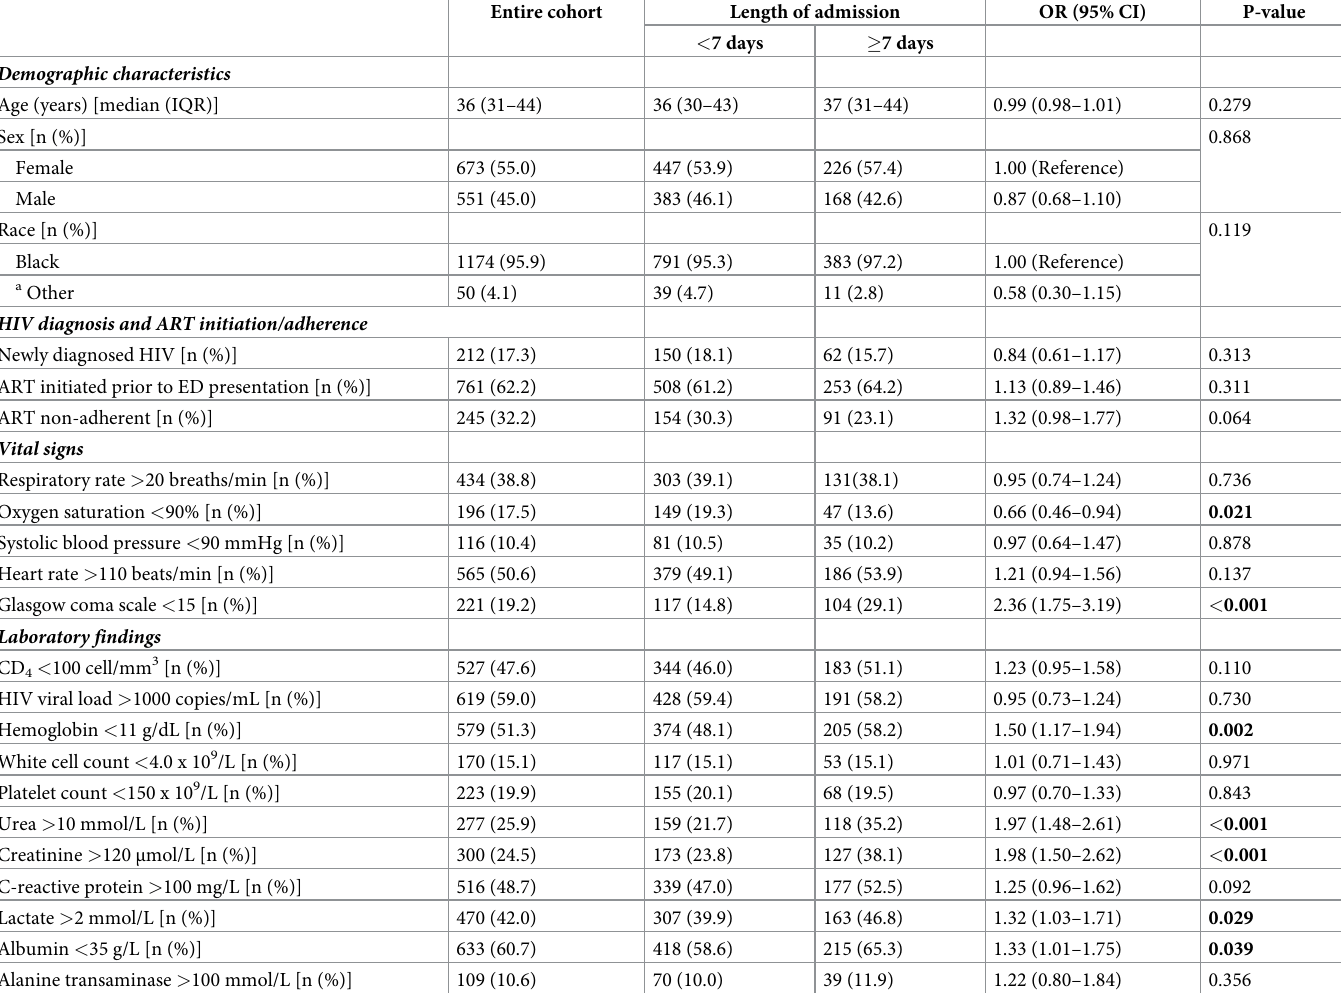
Table 1. Comparison of LOS with respect to demographic details, HIV diagnosis, ART initiation/adherence, vital signs, and laboratory parameters of study